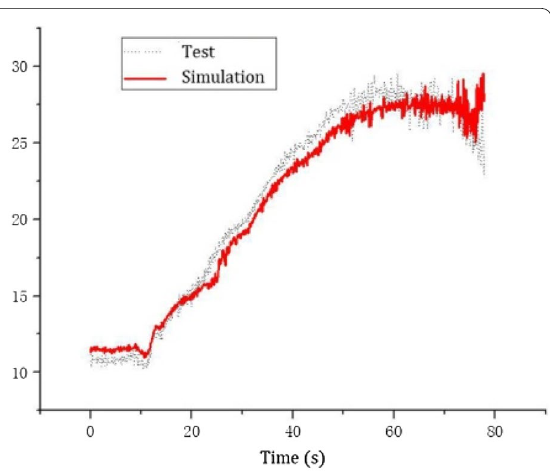
Figure 8 Yaw rate